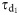
Predicted effects of the key parameters on SSA index (CSI) for the rate model (A-D) and spiking model (E-H). Control parameters are denoted by white circles, PV and SST inactivation parameters are denoted by white triangles, and PV and SST activation parameters are denoted by white squares. The control parameter values, IOpt,PV = IOpt,SST = 0, are denoted by white circles. A, E: PV optogenetic parameter vs recurrent excitation (wee). B, F: SST optogenetic parameter vs recurrent excitation. C, G: PV optogenetic parameter vs thalamic depression time constant τd1. D, H: SST optogenetic parameter vs thalamic depression time constant. White regions in all subfigures denote areas where the firing rate (FR) of the standard tone is too low (FR<0.1), or where the excitatory response saturates, making CSI measurements impossible.